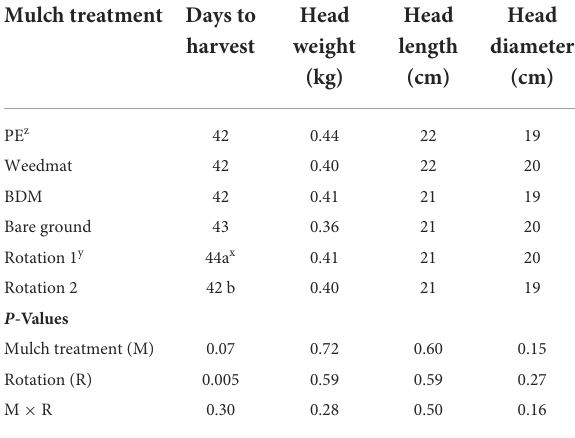
TABLE 5 Canopy cover (%) of lettuce cv. Green Star grown on raised beds with polyethylene (PE), soil-biodegradable mulch (BDM), weedmat, or bare ground treatments in two different rotation schemes following strawberry in a Mediterranean climate, 2021. Mulch treatment